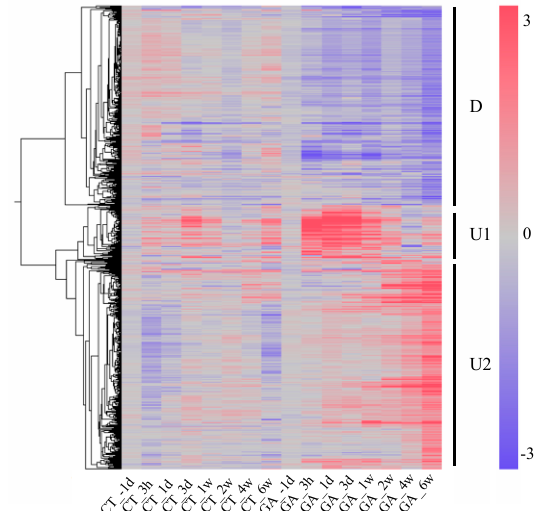
Figure 2. Tree clustering analysis of 881 DEGs. D, U1, and U2 on the right indicate three different clusters of differentially expressed genes (DEGs) used for further analysis. CT_ − 1 d, CT_3 h, CT_1 d, CT_3 d, CT_1 w, CT_2 w, CT_4 w, CT_6 w, GA_ − 1 d, GA_3 h, GA_1 d, GA_3 d, GA_1 w, GA_2 w, GA_4 w, and GA_6 w are sample names.